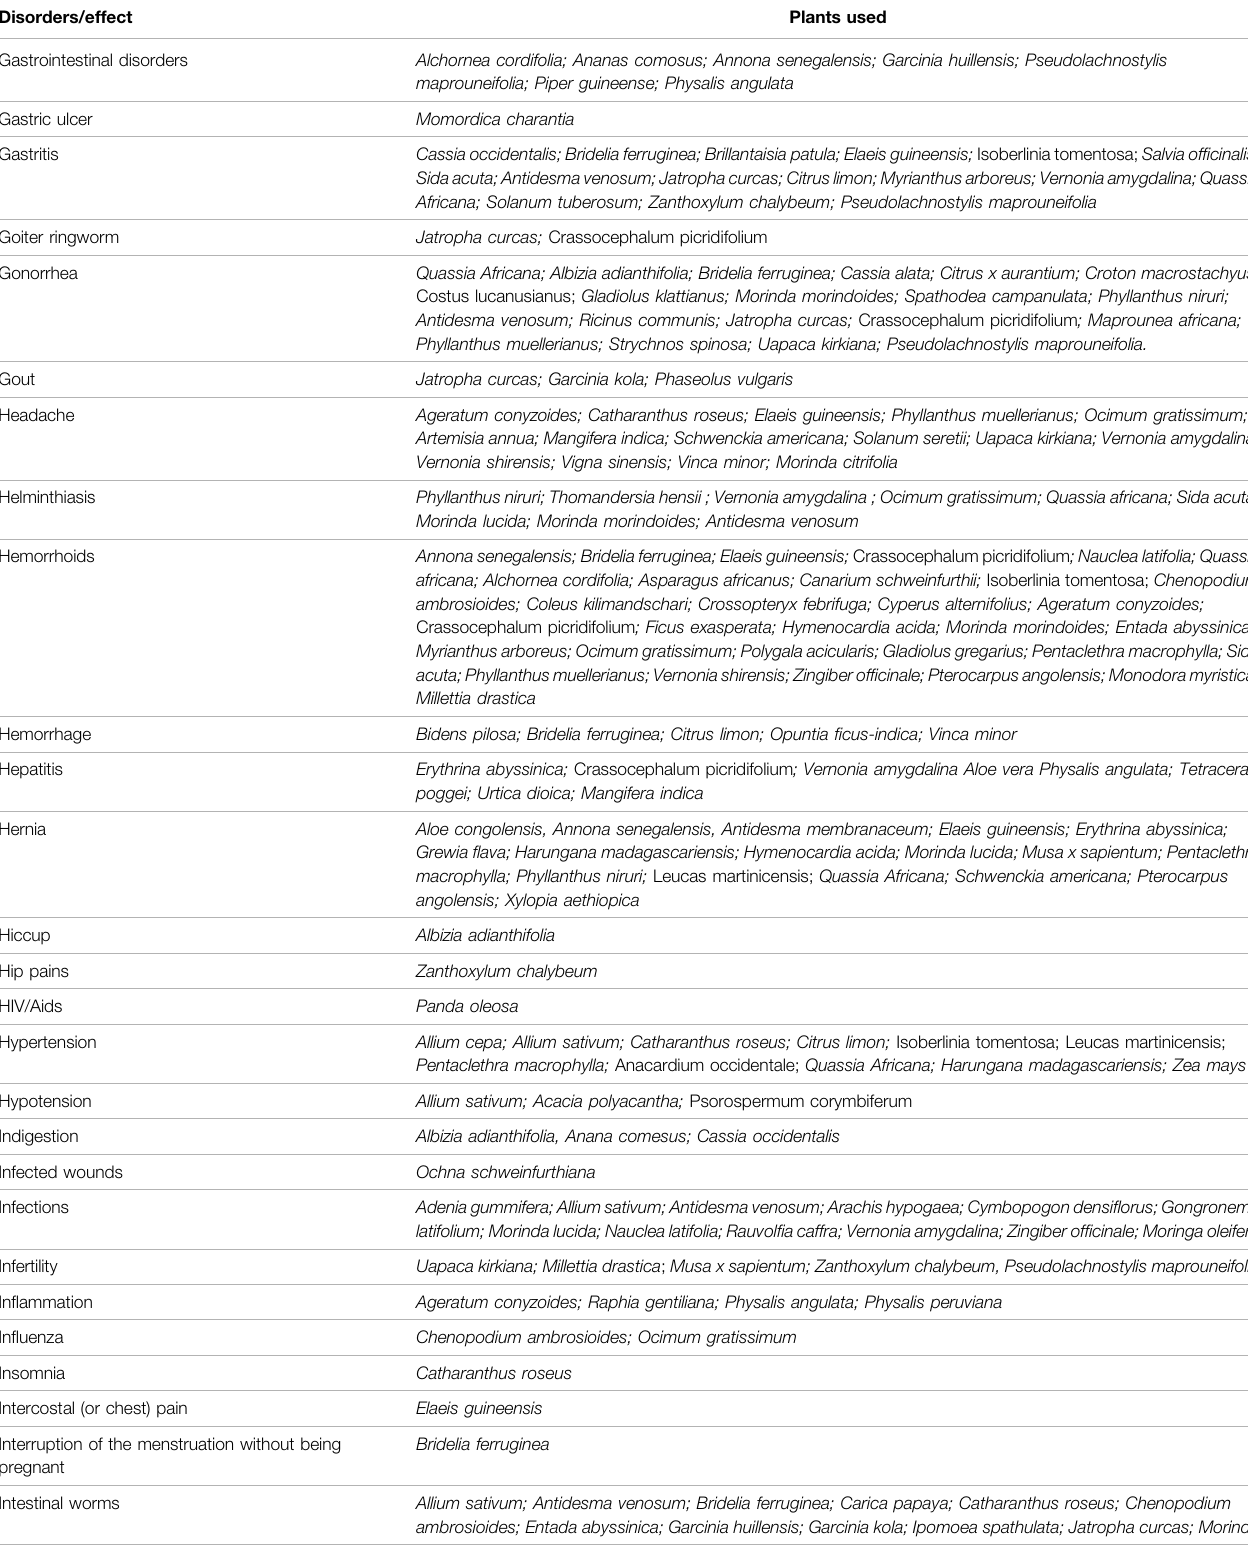
TABLE 3 | ( Continued ) Antidiabetic plants used locally for the treatment of other various